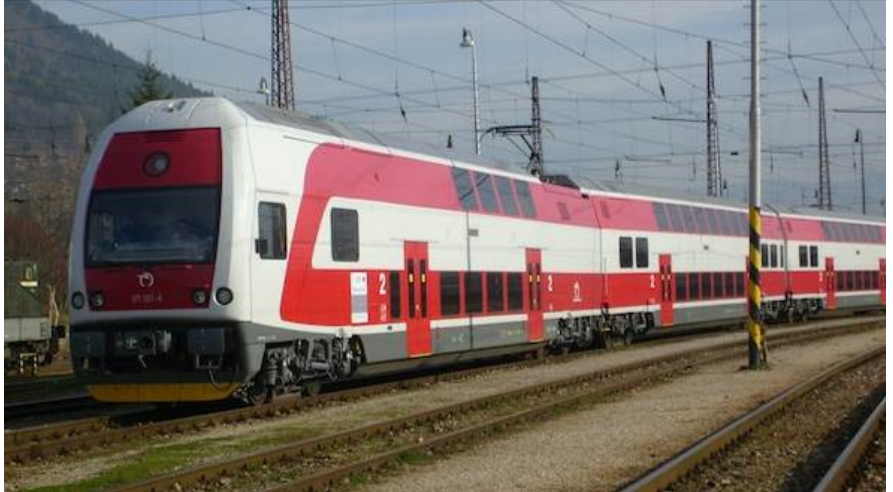
Figure 2. Electric double-decker multiple-unit series 671 [40].